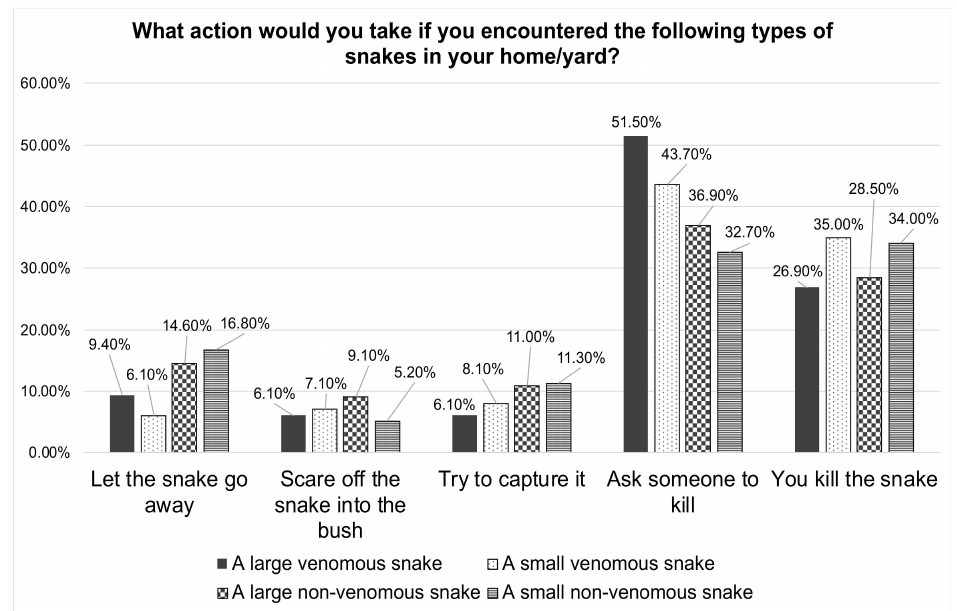
Figure 3. Participants’ perceptions towards encountering different types of snakes in their home or yard.